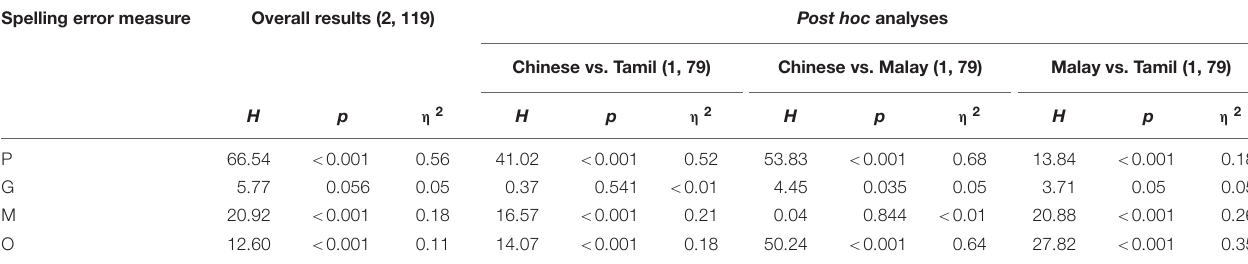
TABLE 6 | Kruskal Wallis analysis of triple-code errors by language groups in the subsample. Spelling error measure Overall results (2, 119) Post hoc analyses Chinese vs. Tamil (1, 79)